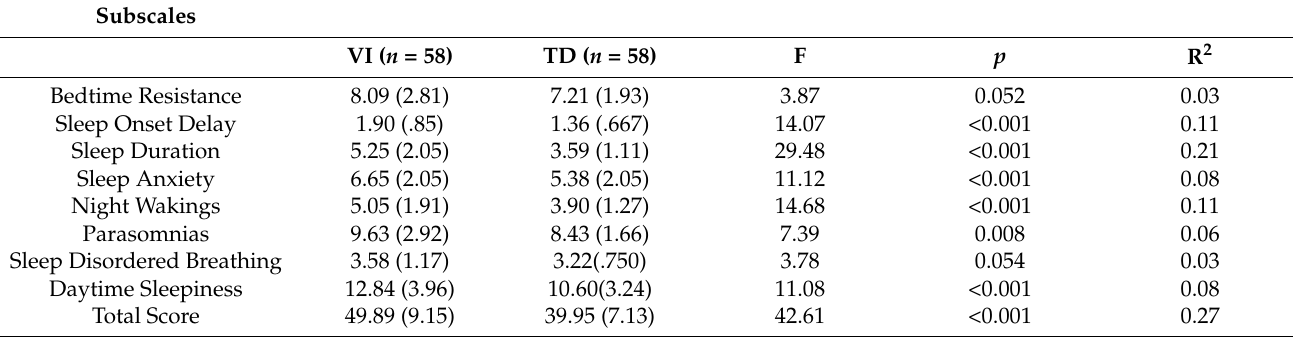
Table 3. Group mean scores, standard deviations, and group differences in CSHQ